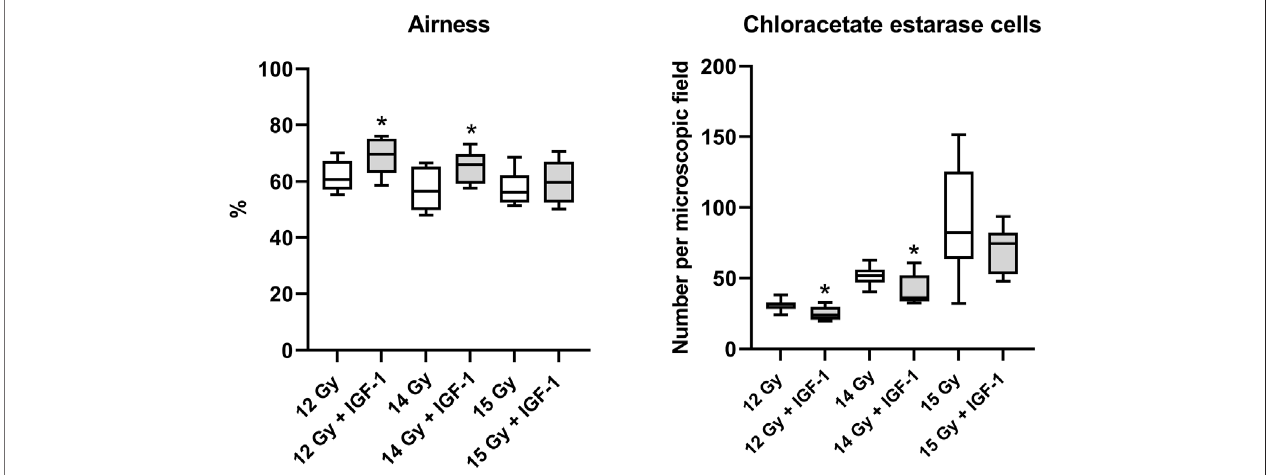
FIGURE 4 | Effect of IGF-1 at 1 mg/kg in the lung of mice irradiated by 12, 14, and 15 Gy with shielded head and neck. A: airness of the tissue. B: chloroacetate esterase-positive cells per microscopic fi eld at ×400 magni fi cation. Signi fi cantly different when compared with the solely irradiated group receiving no treatment: * p ≤